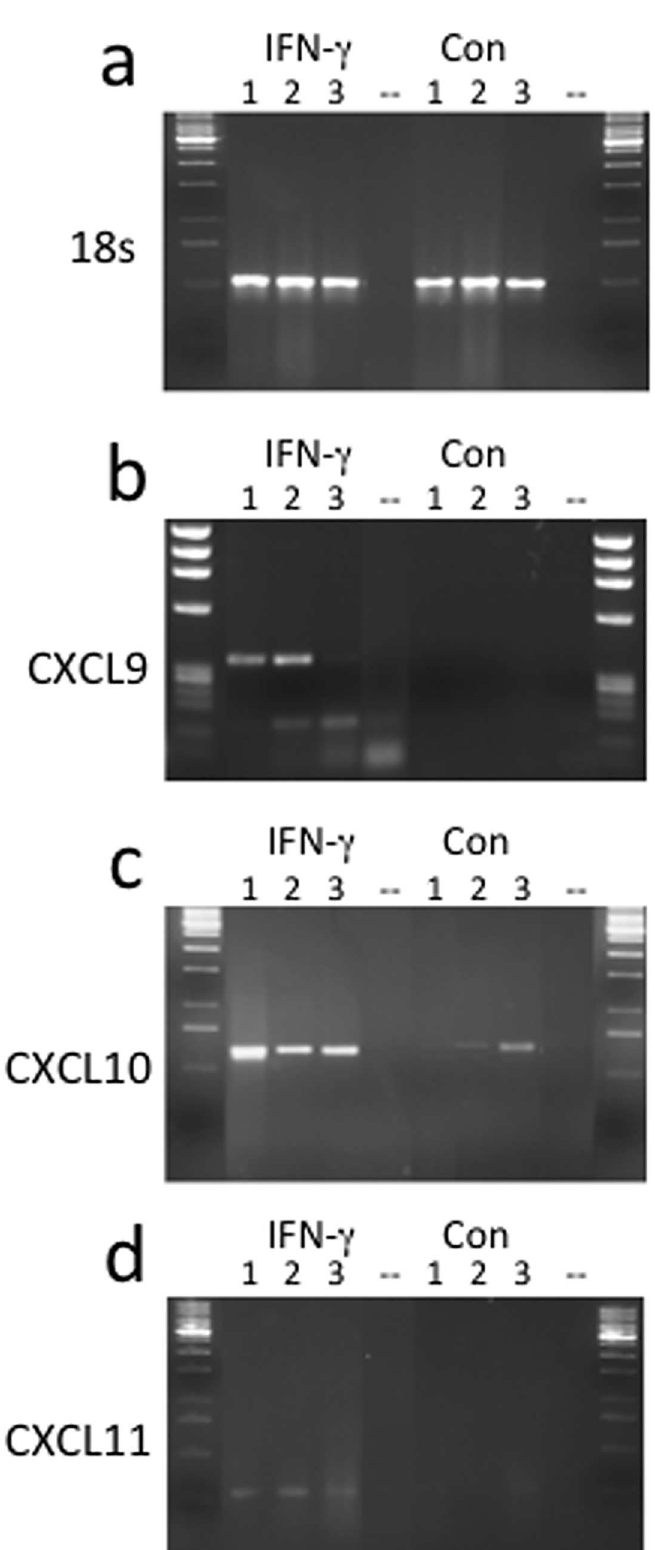
Fig 3. 18S (a), CXCL9 (b), CXCL10 (c) and CXCL11 (d) mRNA expression. mRNA expressionin 3 different normal human oral keratinocytes (NHOK), either IFN- γ treated for 48 hours (ifn) or control cells that were left untreatedfor 48hrs (con).